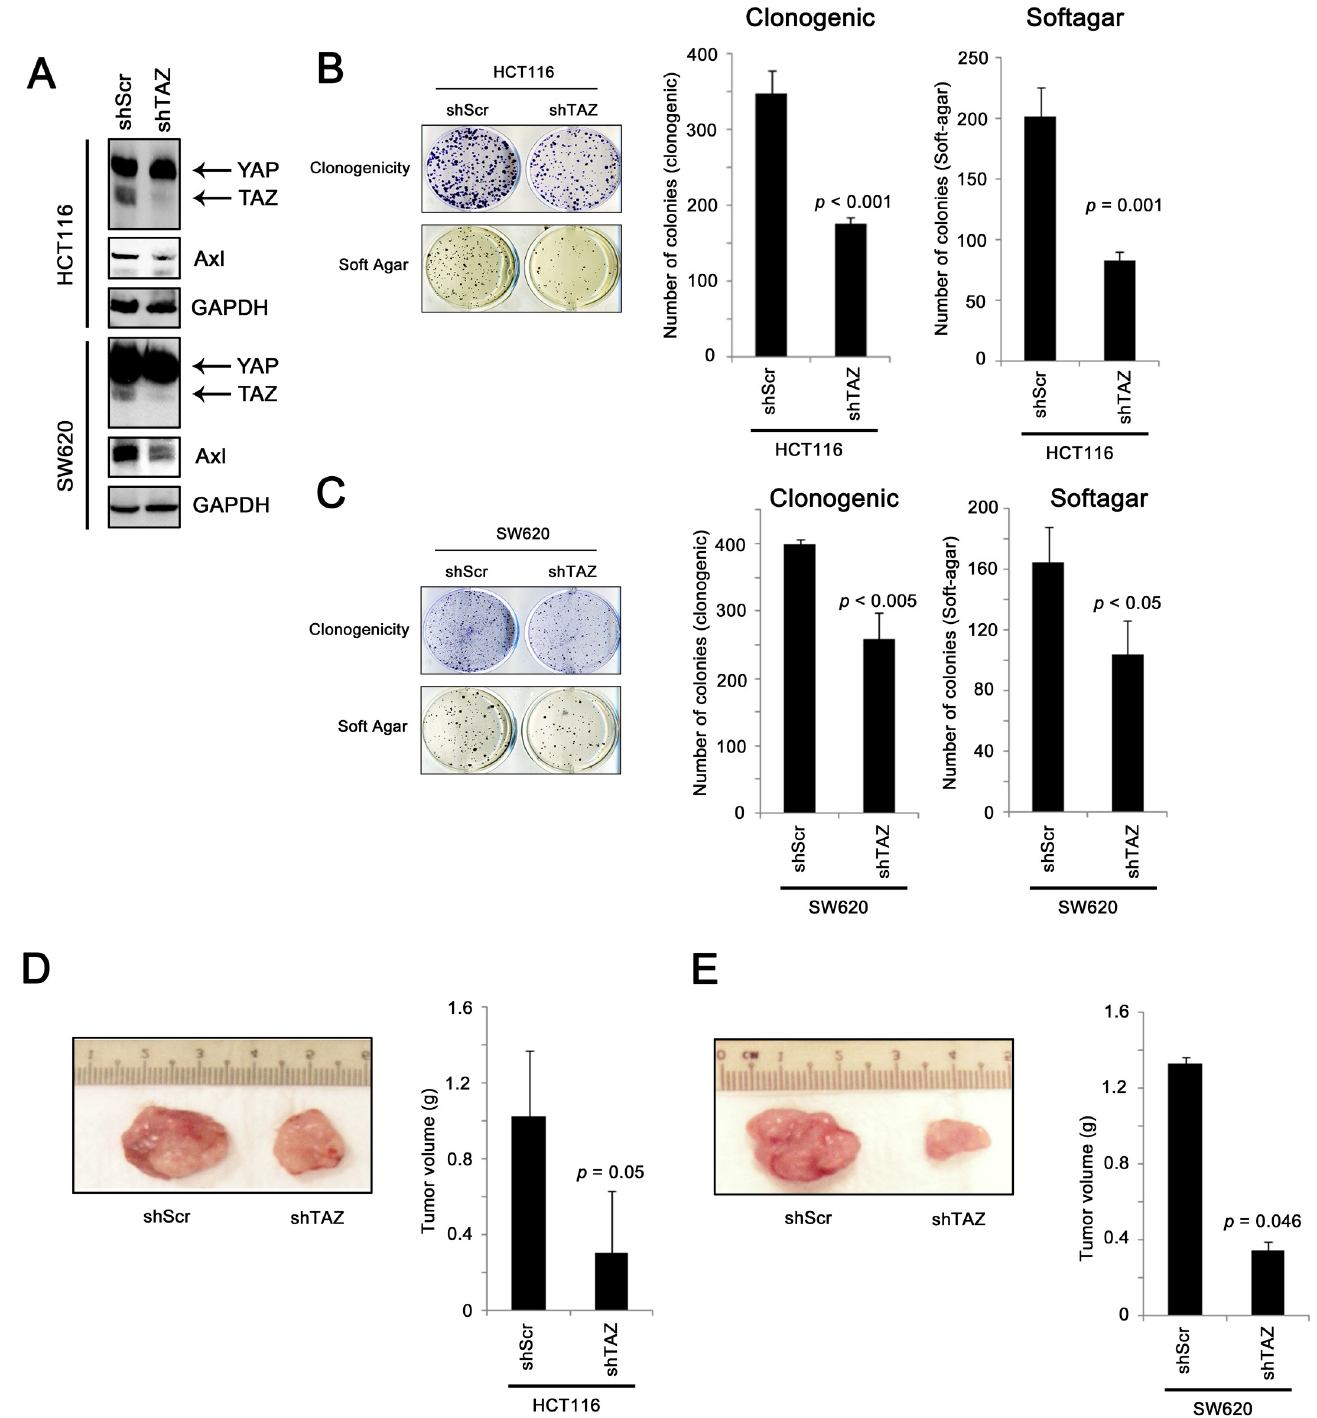
Fig 7. In vitro and in vivo assays for colon cancer cells expressing scramble shRNA or TAZ shRNA. (A) Western blot showing that shTAZ specifically knockdown TAZ, but not YAP, and that AXL was down-regulated in shTAZ cells compared to shScr cells. (B) The clonogenicity and non-adherent growth of HCT116 cells expressing shScr or shTAZ were assessed and the number of colonies formed from three repeats was recorded (C) The clonogenicity and non- adherent growth of SW620 cells expressing shScr or shTAZ were assessed and the number of colonies formed from three repeats was recorded. (D) The in vivo tumorigenicity of HCT116 cells expressing shScr or shTAZ was assessed in nude nice, and the tumor formed was excised and weighted (n = 3 in each group). (E) The in vivo tumorigenicity of SW620 cells expressing shScr or shTAZ was assessed in nude nice, and the tumor formed was excised and weighted (n = 3 in each